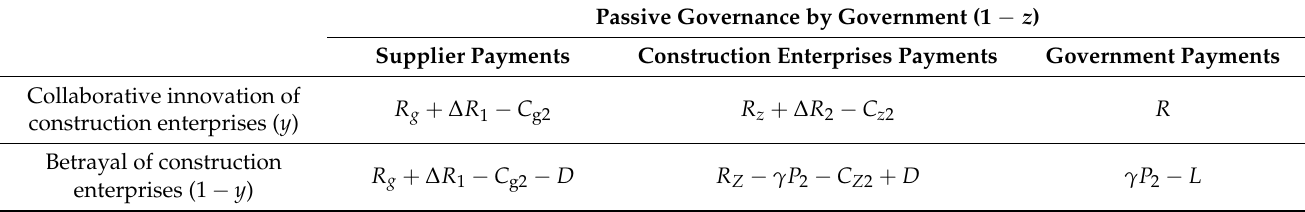
Table 2. The tripartite game payment matrix of suppliers’ participation in collaborative innovation of green building projects of construction enterprises ( x